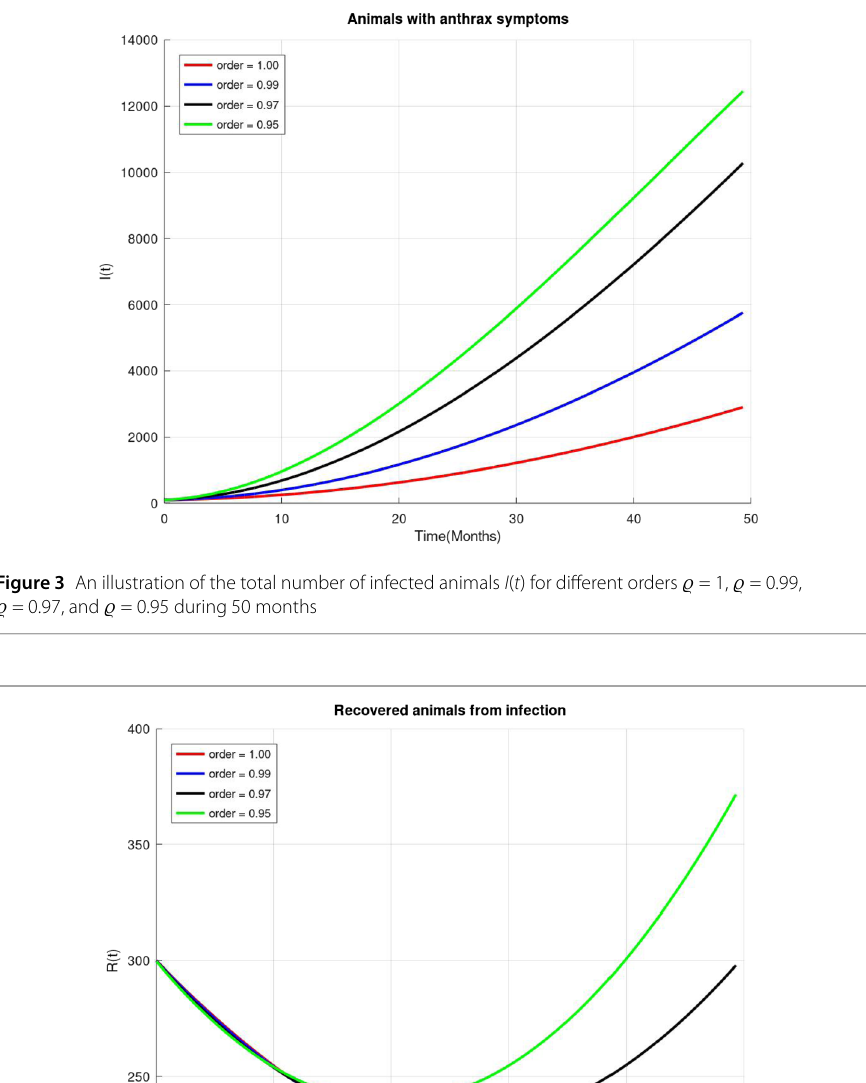
on the observations of this figure, we see that the total number of the susceptible animals increases by passing the time, this animal class is highly infected by anthrax disease, and the transmission rate of this disease remains high. In Figs. 2, 3, 4, 5, we plot the three-term approximate solutions of the fractional anthrax disease model by applying the homotopy analysis transform method (HATM) with auxiliary parameter h = –1 and auxiliary func- tion H ( t ) = 1 for different values of order (cid:2) . In each diagram, the solid red line illustrates the solution functions for integer order (cid:2) = 1. These four Figs. 2, 3, 4, 5 indicate that